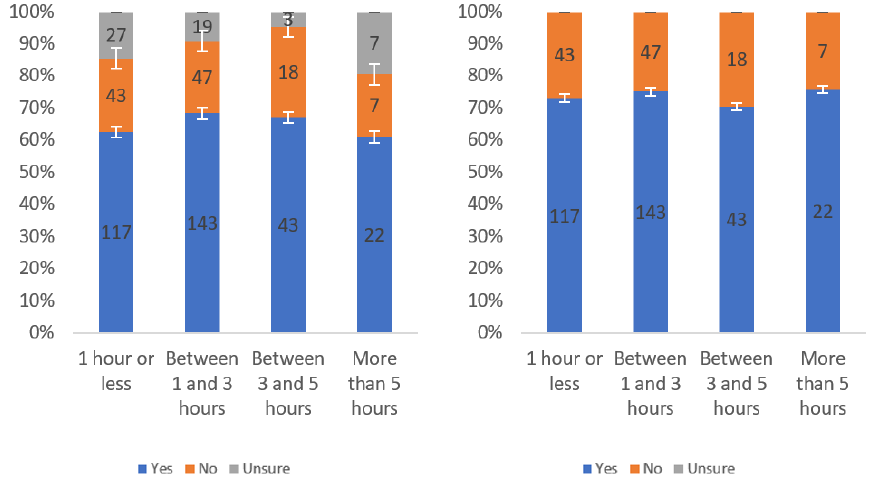
Figure 15. Responses regarding respondents’ willingness to review by internet usage level including ( left ) and excluding ( right ) unsure responses.